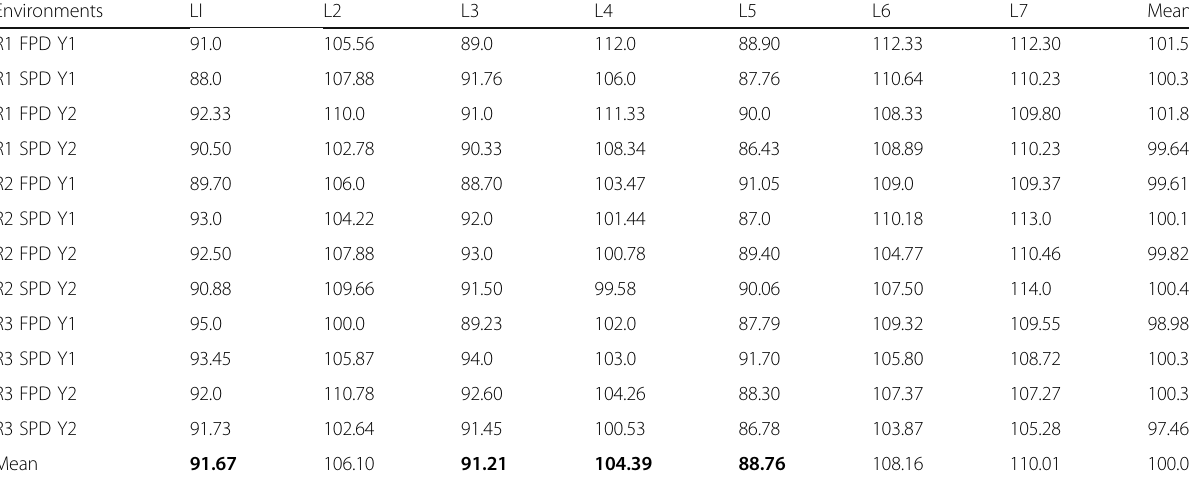
Table 5 The mean values for the seven rice entries under the 12 environments for heading date